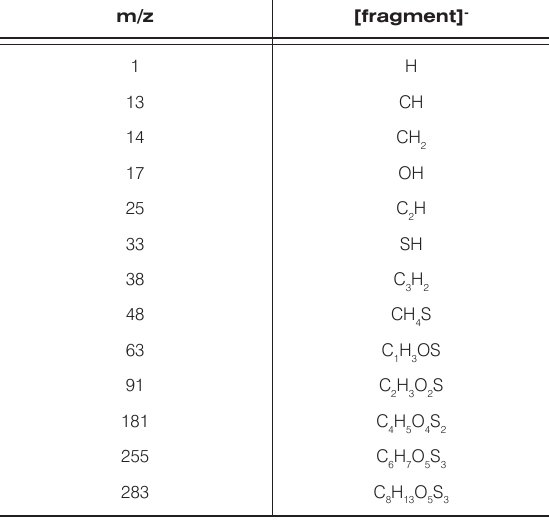
Table 1B. Table of fragments of hexadecanethiol SAM onto the Ag in positive